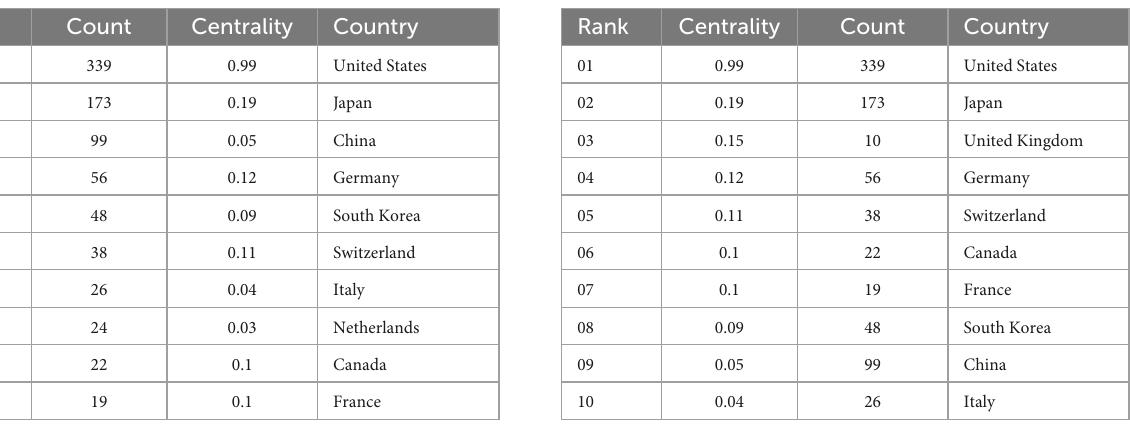
TABLE 1 Ranking of countries in terms of publications (top 10). TABLE 2 Ranking of countries in terms of centrality (top